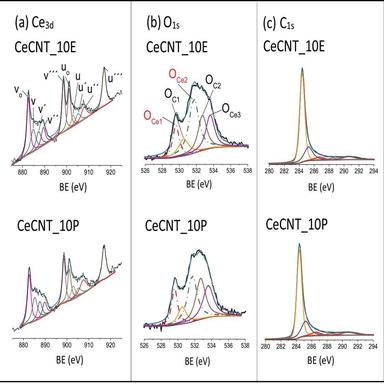
a) Ce3d b) O1s and c) C1s XPS spectra for CeCNT_10E and CeCNT_10P composites.